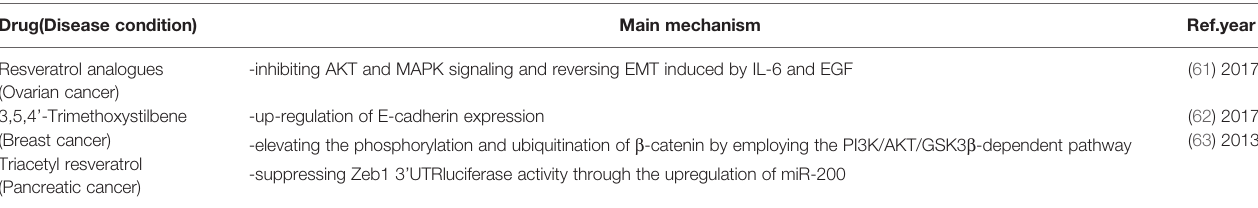
TABLE 2 | Summary of mechanisms by which resveratrol descendant inhibits the EMT